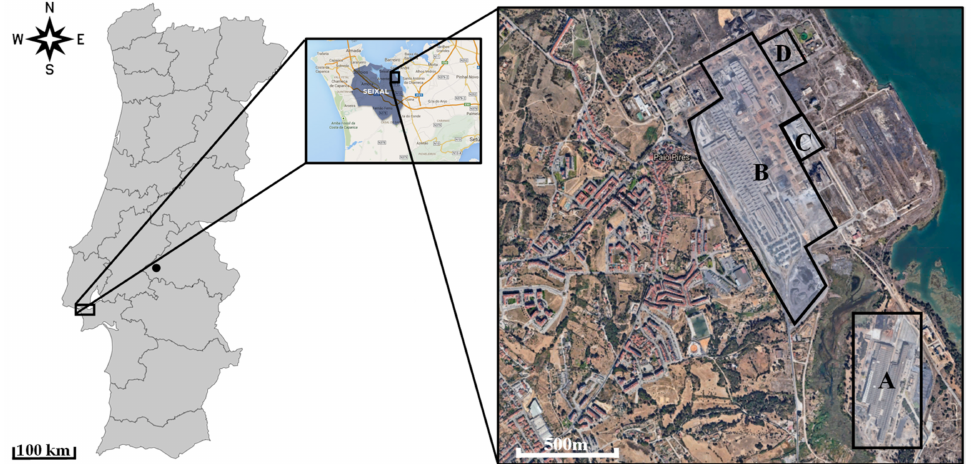
Figure 1. Location of the study area: ( left ) Framework of the study area (black rectangle) and the clean area (black dot, Montargil) in Portugal mainland; ( center ) Seixal municipality location; ( right ) location of industries A, B, C and D within the study area (geographical data obtained from Google Earth Pro [30]).